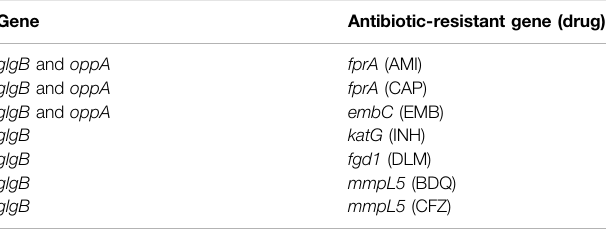
TABLE 2 | Antibiotic-resistant genes reported by the WHO catalogue are found in the epistatic network. Gene Antibiotic-resistant gene (drug) glgB and